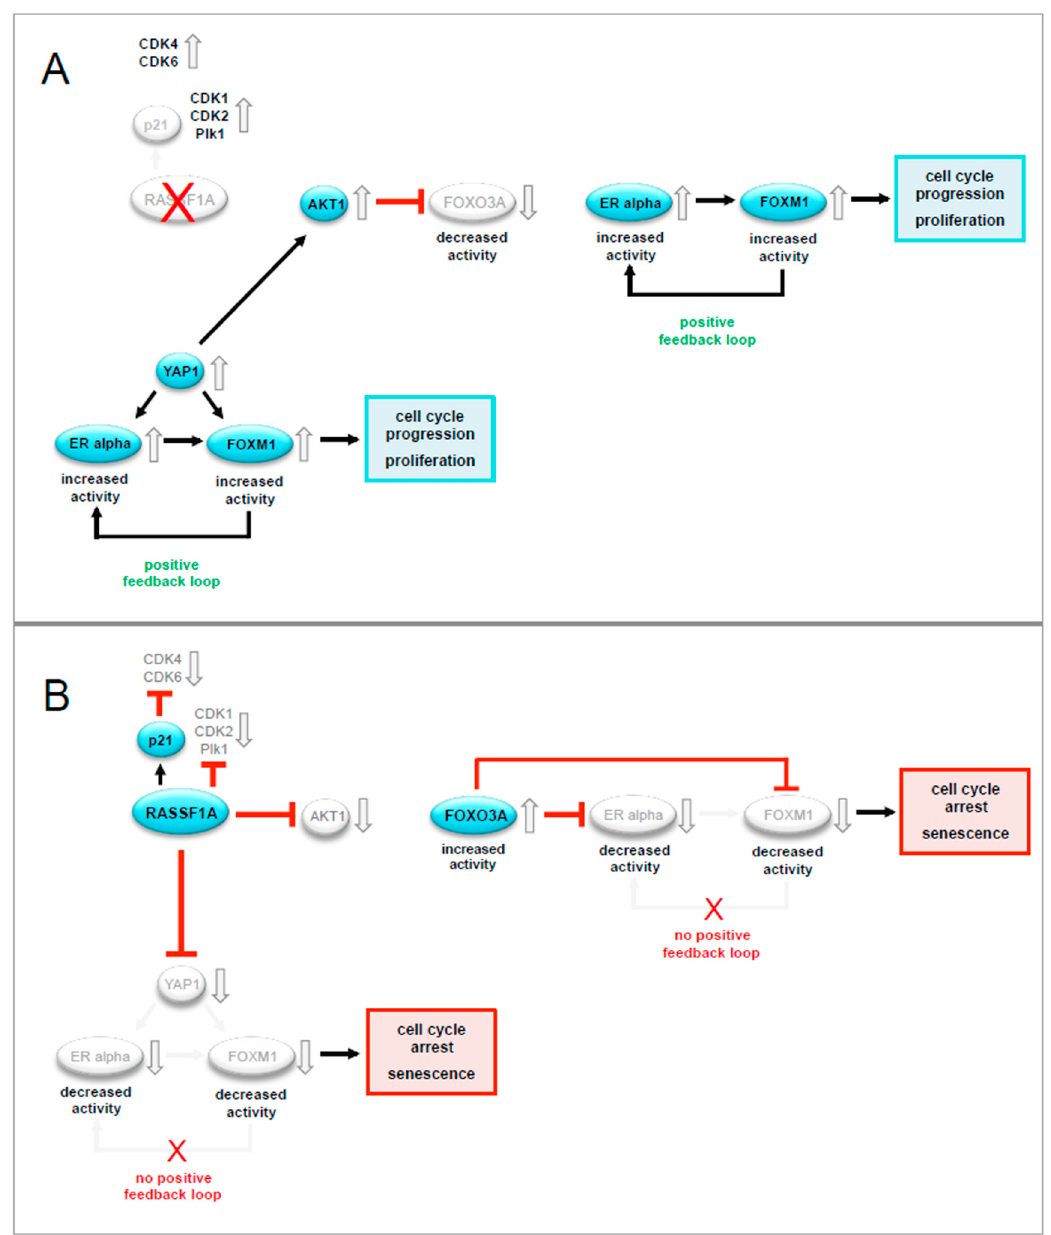
Figure 9. Schematic model of a possible molecular network between RASSF1A, the Hippo pathway effector YAP1, AKT, FOXO3A, FOXM1, and ER α based on the findings in this paper and on the published literature. ( A ) In the absence of RASSF1A, the Hippo pathway effector YAP1 is active and affects the expression and activity of ER α and FOXM1, directly and indirectly. First, YAP1 causes expression of FOXM1 and the ER α leading to increased levels of both proteins. Second, YAP1 also causes increased activity of AKT1 [27]. AKT1 phosphorylates FOXO3A and subsequently curtail its activity. FOXO3A can counteract ER α activity [21]. Under the influence of E2, ER α binds to the FOXM1 promoter and induces FOXM1 expression. Vice versa, FOXM1 can bind to the ER α promoter, maintaining, or increasing ER α expression in a positive feedback loop between both proteins. This feedback loop is sustained in the presence of E2. As FOXM1 is a key regulator of cell cycle progression, deregulated FOXM1 expression leads to uncontrolled proliferation and resistance against senescence. ( B ) RASSF1A interferes with the network outlined in (A) by inhibiting YAP1 and AKT1 signaling, thereby increasing the activity of FOXO3A. FOXO3A can inhibit ER α and FOXM1 by two different